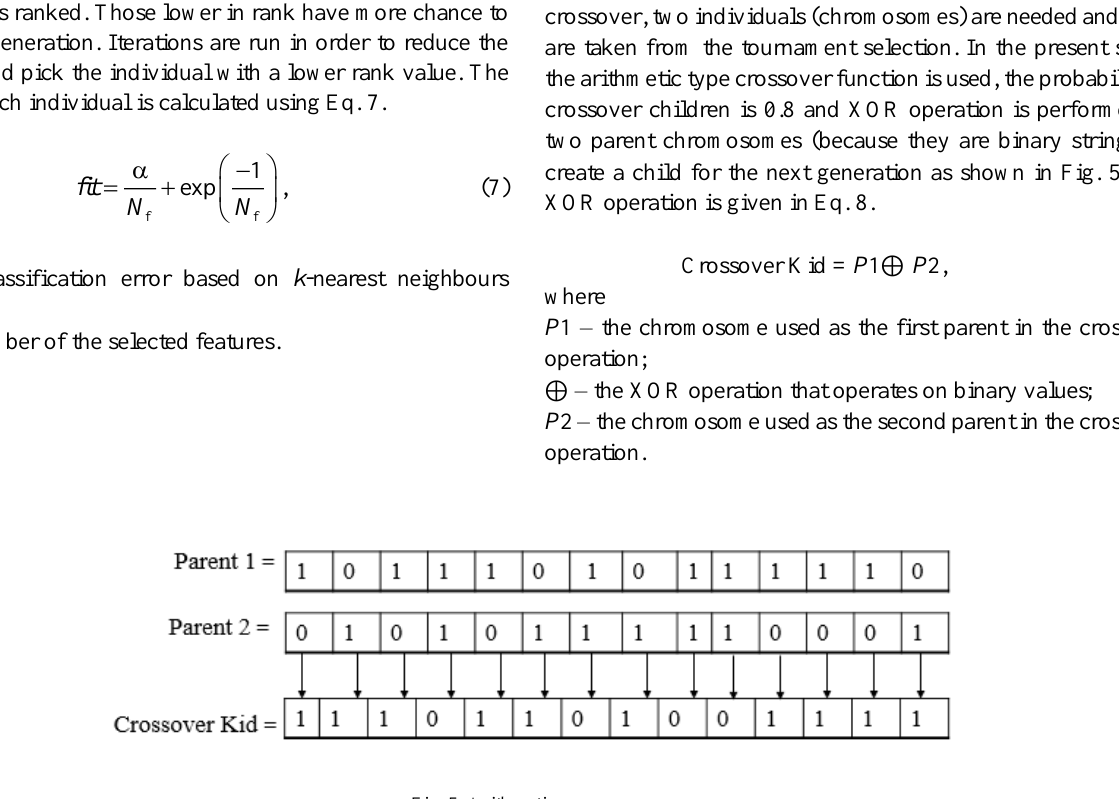
Fig. 5. Arithmetic